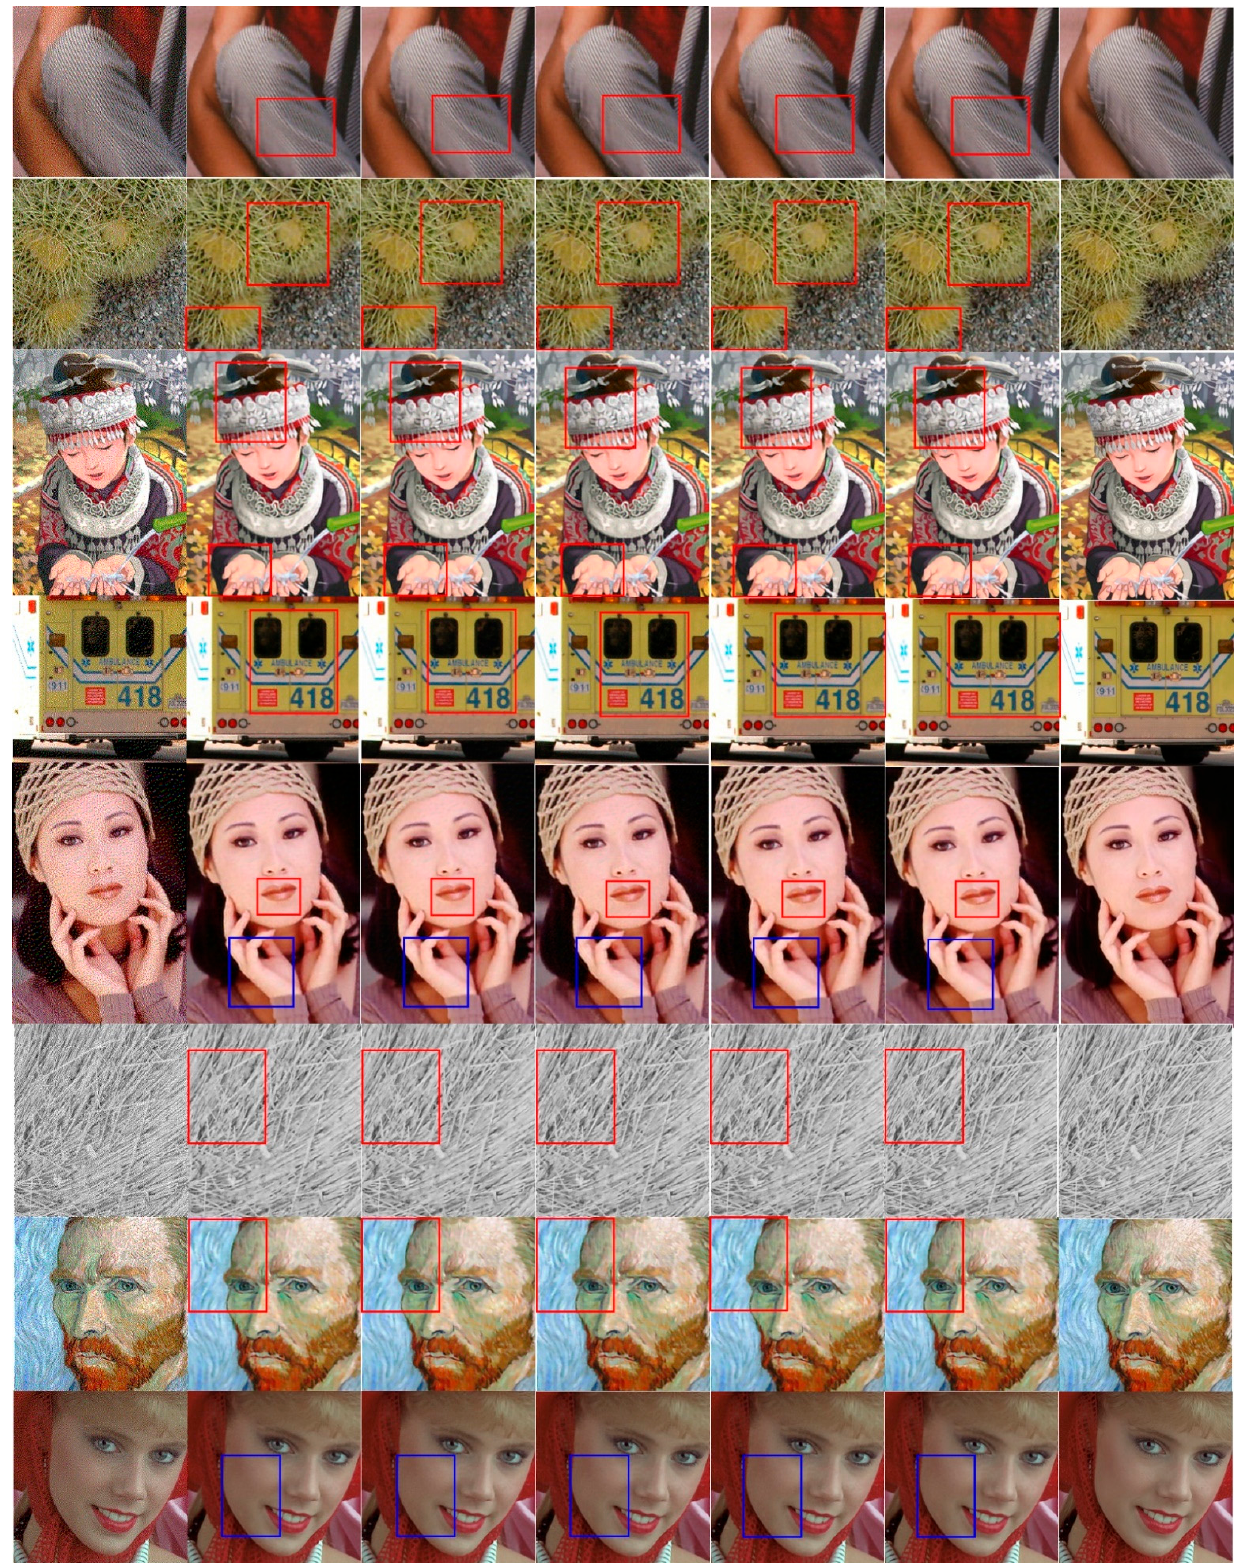
Figure 7. Experimental results for a small texture dataset: halftoned images, images reconstructed using DCNN [37], images reconstructed using U-net [35], images reconstructed using DDN [39], images reconstructed using PRL [23,25], images reconstructed using the proposed SALDL method, and original images (left to right).